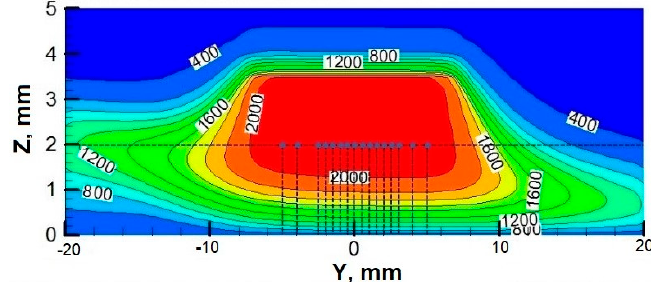
Figure 8. Schematic of the initial settings for tracked particles (The case with ω = 300 rpm).